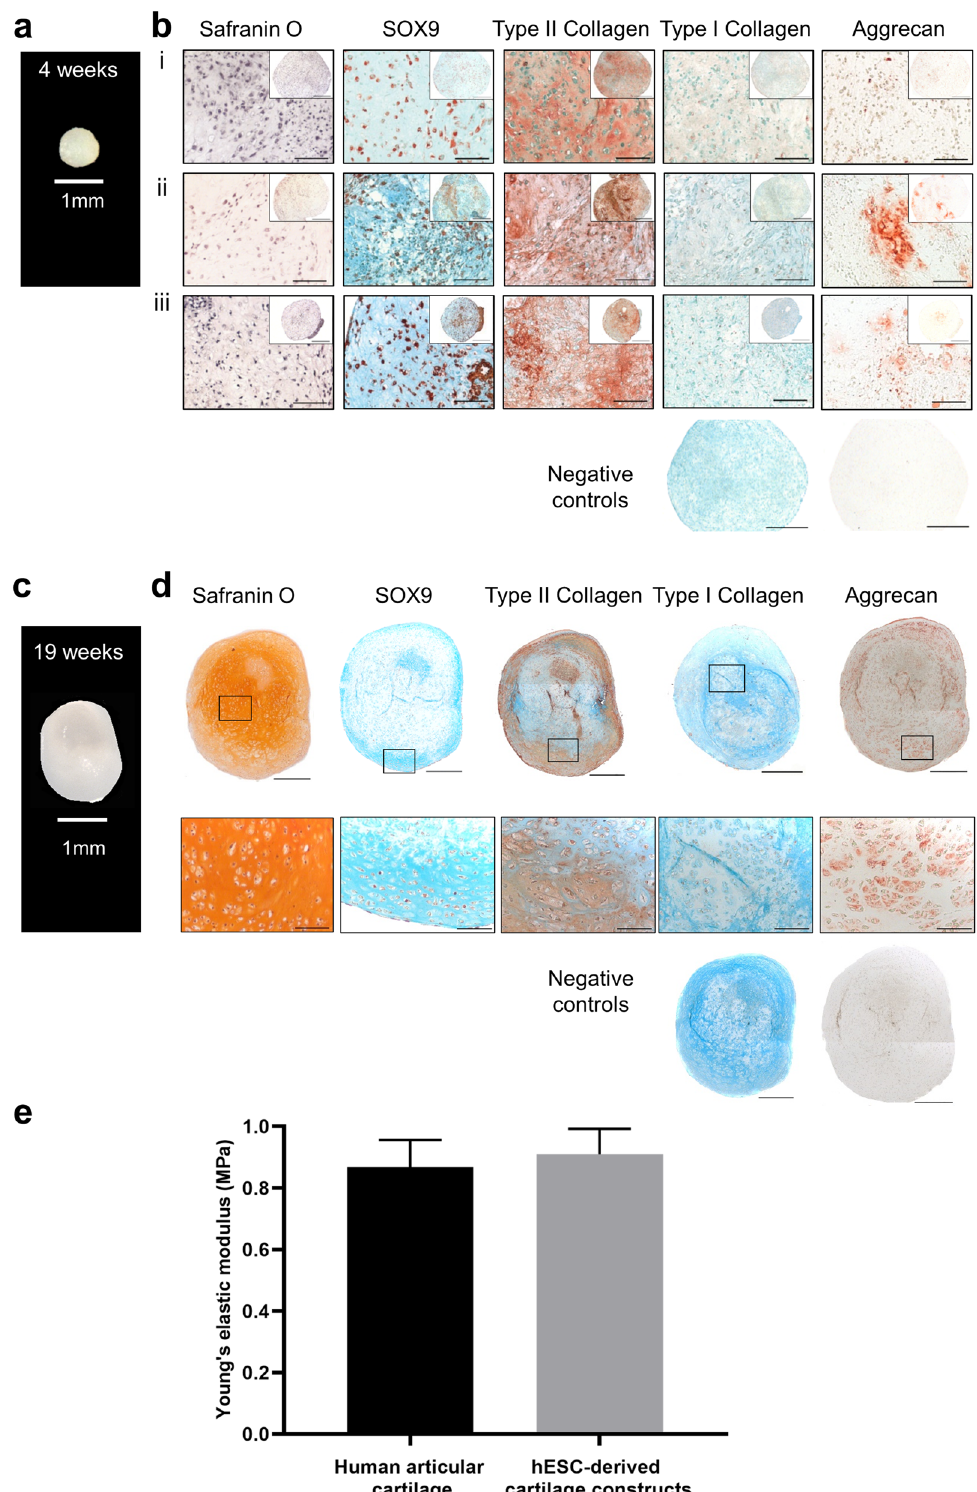
Figure 2. Histological and mechanical characterisation of 3D hESC-derived cartilage tissue constructs. A photograph of a representative 4-week cartilage tissue construct ( a ) measuring 1 mm in diameter. Characterisation of representative 4-week hESC-derived cartilage tissue constructs generated from 3 independent experiments ( b i, ii and iii) using Safranin O staining and immunohistochemistry to detect SOX9, Type II collagen, Type I collagen and Aggrecan. A photograph of a representative 19-week cartilage tissue construct ( c ). Characterisation of a representative 19-week hESC-derived cartilage tissue construct ( d ) using Safranin O staining and immunohistochemistry to detect SOX9, Type II collagen, Type I collagen and Aggrecan. The negative controls represent omission of the primary antibody. Sections immunolabelled for SOX9, Type II collagen, Type I collagen and associated negative controls are counterstained with Alcian blue. Scale bars represent 500 µm (low magnification) or 100 µm (high magnification). Graph showing values for elastic (Young’s) moduli (MPa) of 19-week hESC-derived cartilage tissue constructs (n = 3 biological replicates) and full-thickness human articular cartilage (n = 9 biological replicates) ( e ). Values represent mean ±